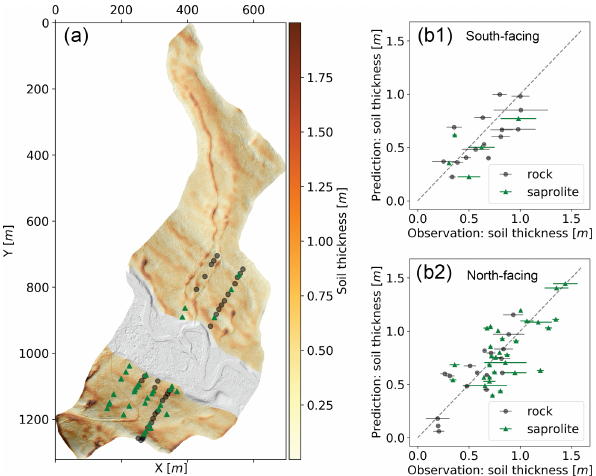
Figure 4. Soil thickness map. (a) Spatial map of soil thickness from modeling. Panels (b1) and (b2) show a comparison between model and field measurements for the south-facing and north-facing hill- slopes, respectively. The error bars along the x axis are the differ- ences between auger and CPT data. Gray and green dots present the bottom of the sampling site as bedrock and saprolite, respec- tively. The correlations, RMSEs, and p values are 0.71, 0.18m, and 4 . 2 × 10 − 4 and 0.77, 0.19m, and 2 . 32 × 10 − 10 for south-facing and north-facing hillslopes, respectively. Note that the sampling points in the floodplain zone are excluded because our hybrid model aims to predict the soil thickness in